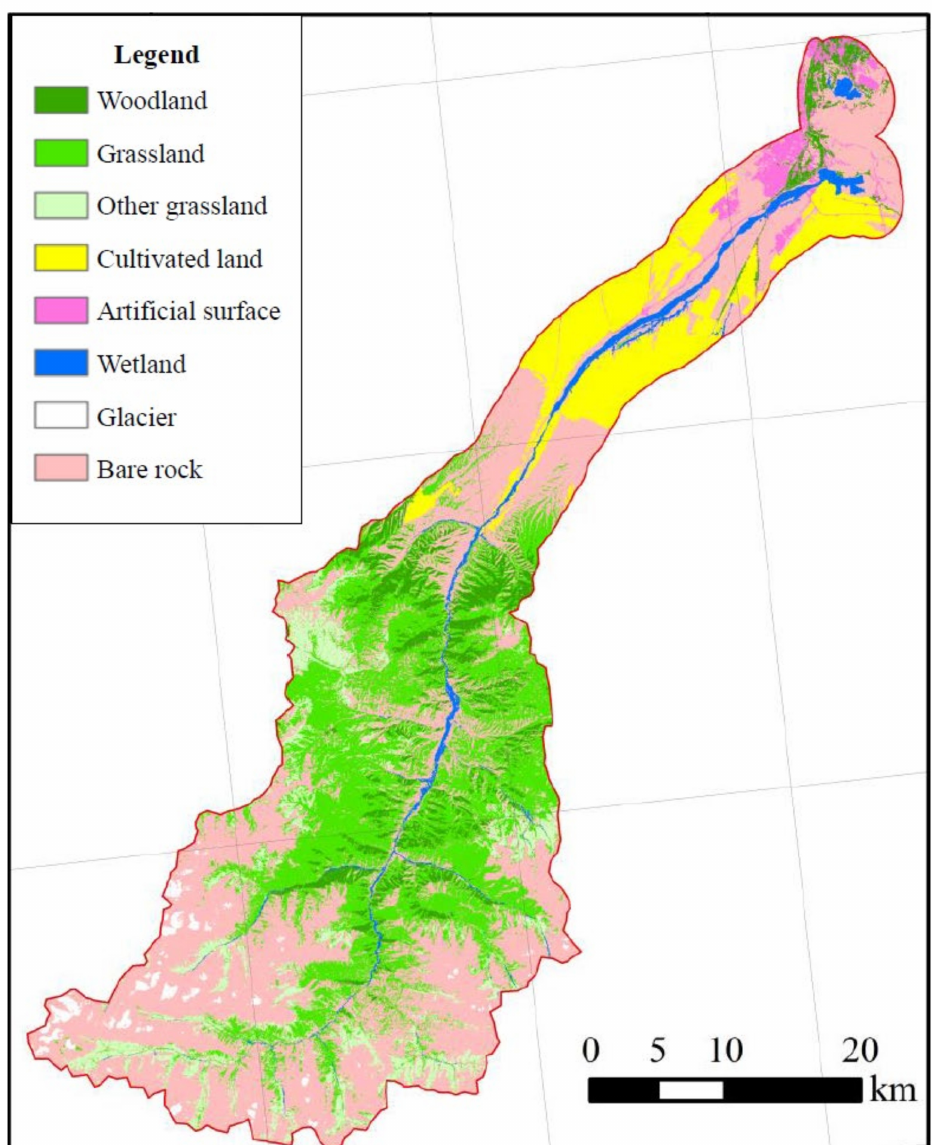
Figure 3. Land use types within the study area